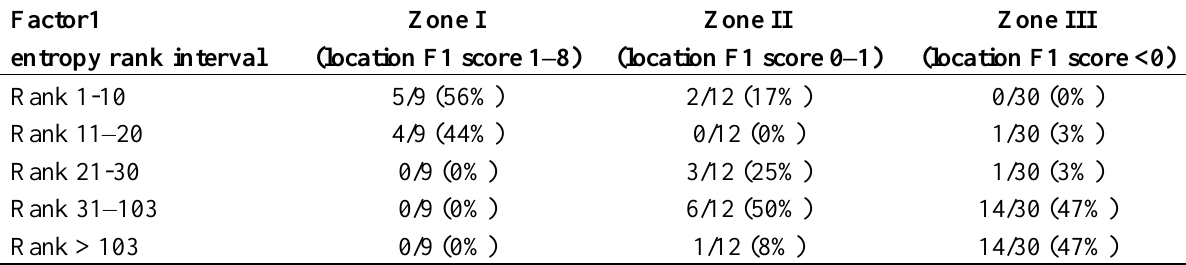
Table 6. Statistics on the ranks of information entropy values for Factor 1 on the southwestern coast of